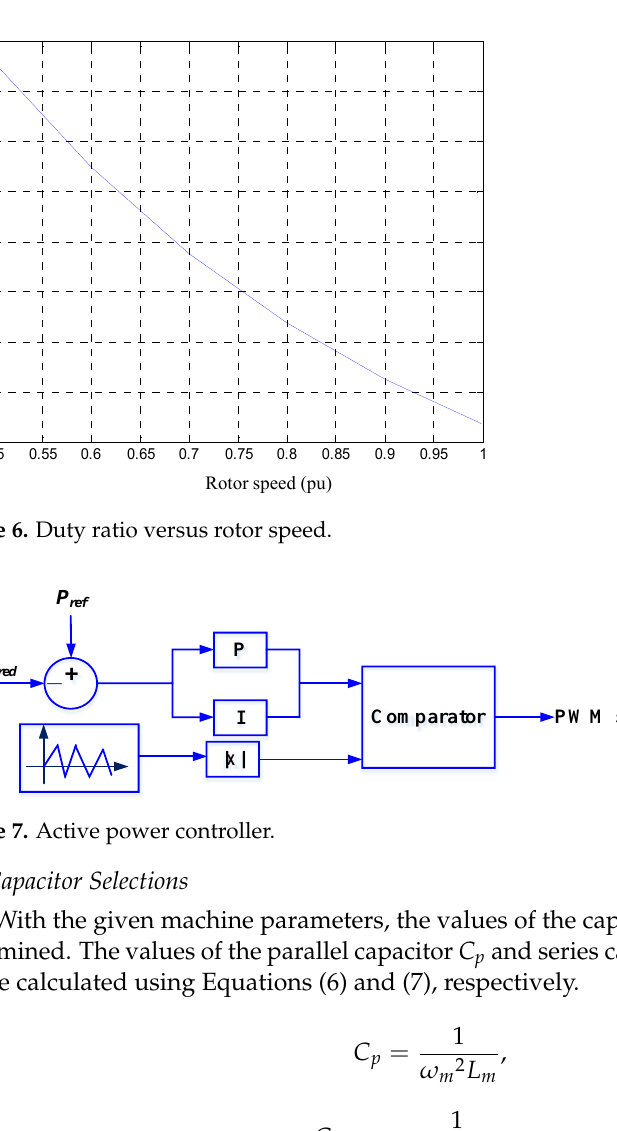
Figure 5. Efficiency versus rotor speed.